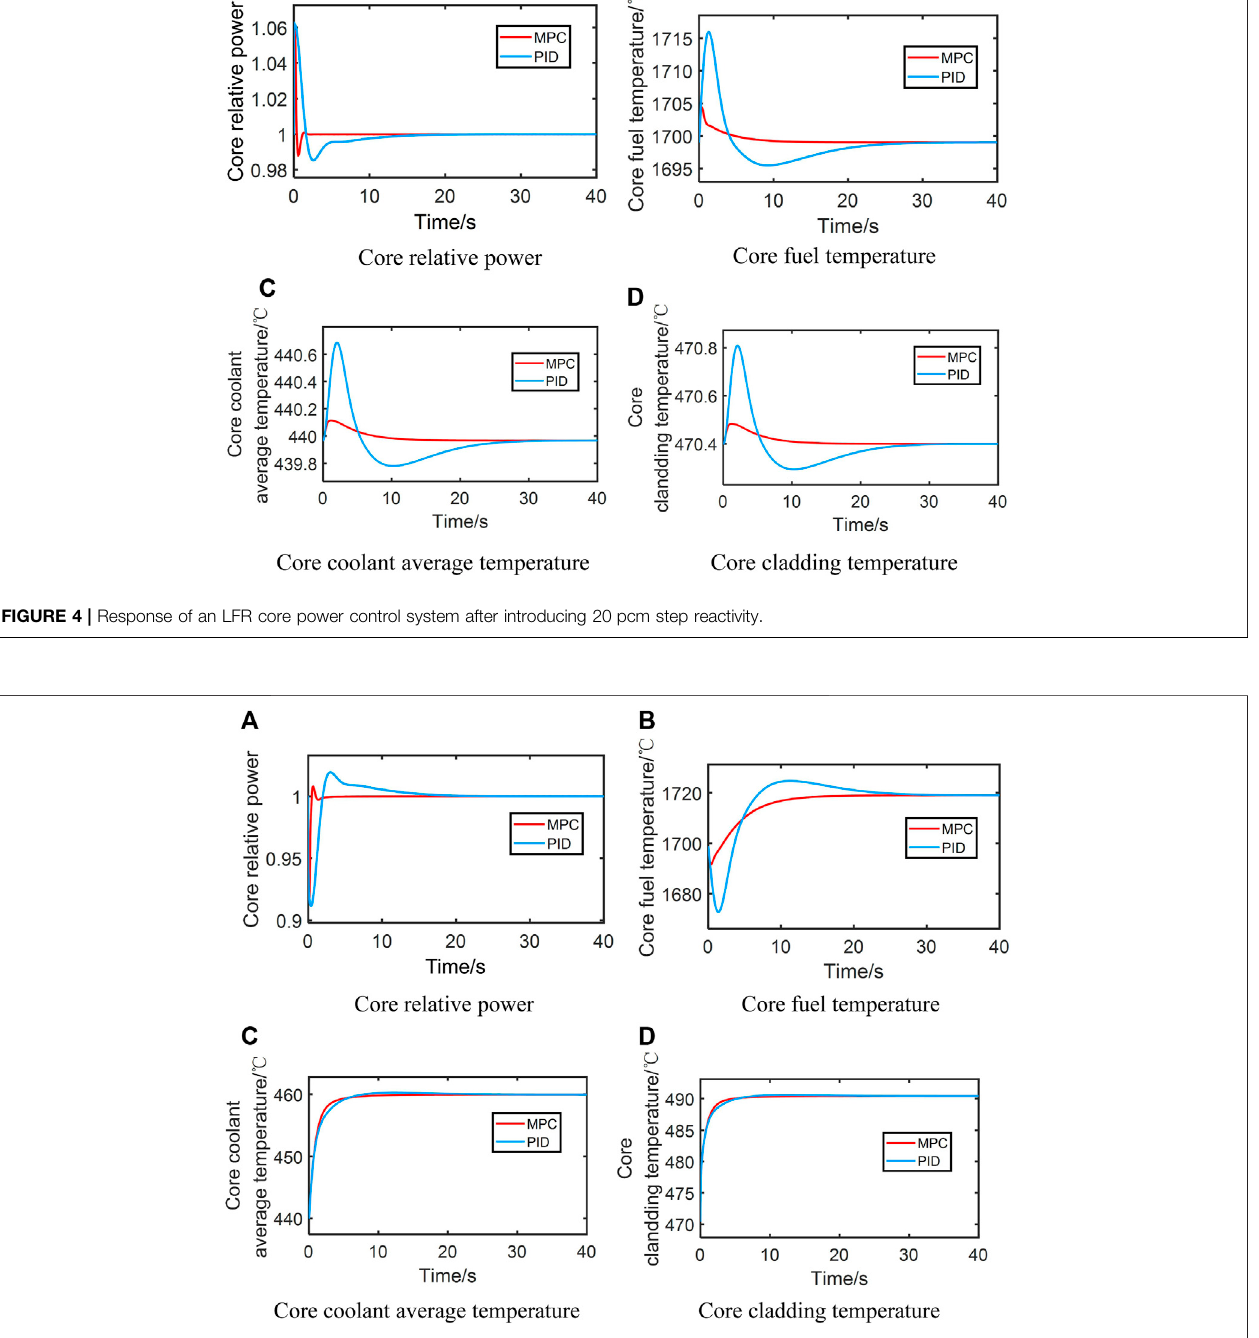
Frontiers in Energy Research |